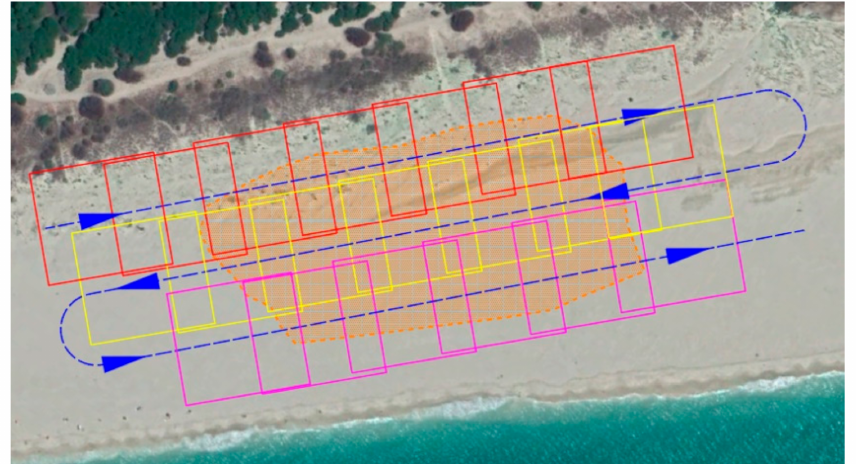
Figure 5. Image of the flight plan indicating the area of interest and frame overlap. The overflight area is bigger than the study